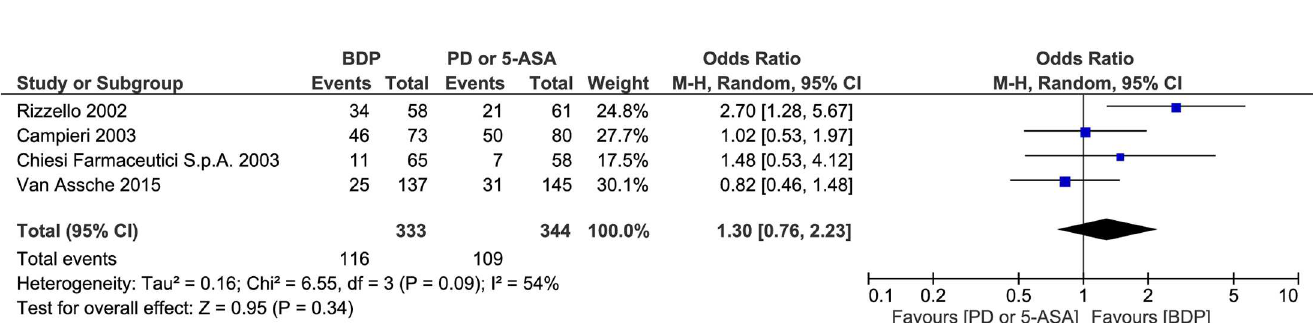
Fig 3. Forest plot of randomized controlled trials of oral BDP vs. oral PD or 5-ASA in inducing clinical response in ulcerative colitis. BDP, beclomethasone dipropionate. PD, prednisone.5-ASA, mesalazine. M-H, Mantel-Haenszel.